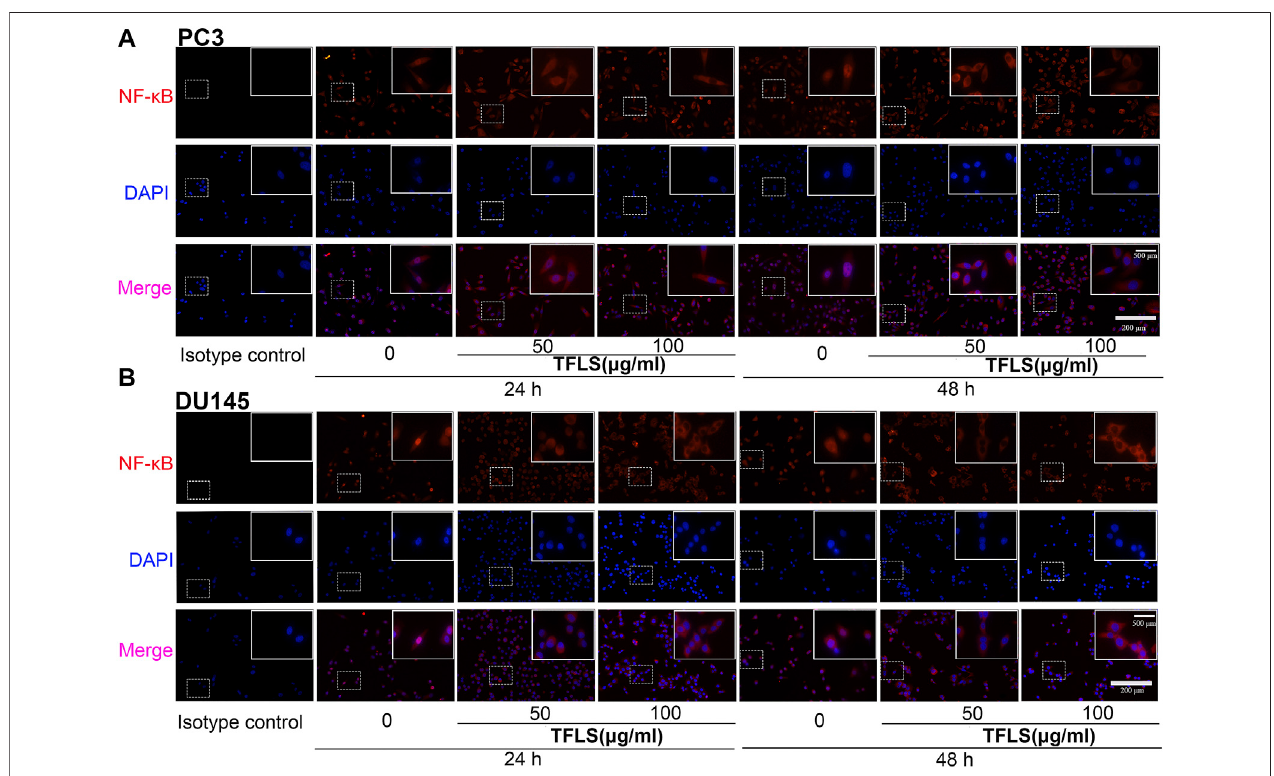
FIGURE8| TFLSinhibitedthenucleusexpressionofNF- κ BinPCacells. (A – B) Representativeimagesofimmuno fl uorescencestainingshowingNF- κ Bp65(red)in PC3 and DU145 cells treated without or with TFLS (50, 100 μ g/ml). Cell nuclei were detected by DAPI (blue). The images were obtained by fl uorescence microscope.